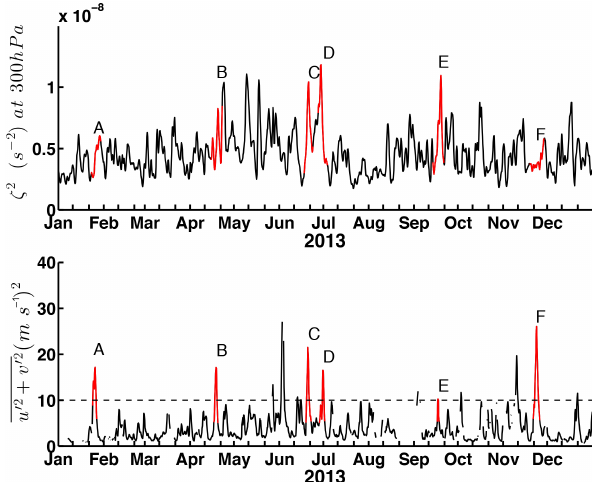
Figure 11. Change of squared relative vorticity (average for an area around Syowa Station) with the time (upper panel) and change of horizontal perturbation variance with the time (lower panel). Peri- ods of further studied Cases A to F are denoted by the red colour. On the time axis each month is represented by three ticks, the first two representing 10days and the last one the reminder of the